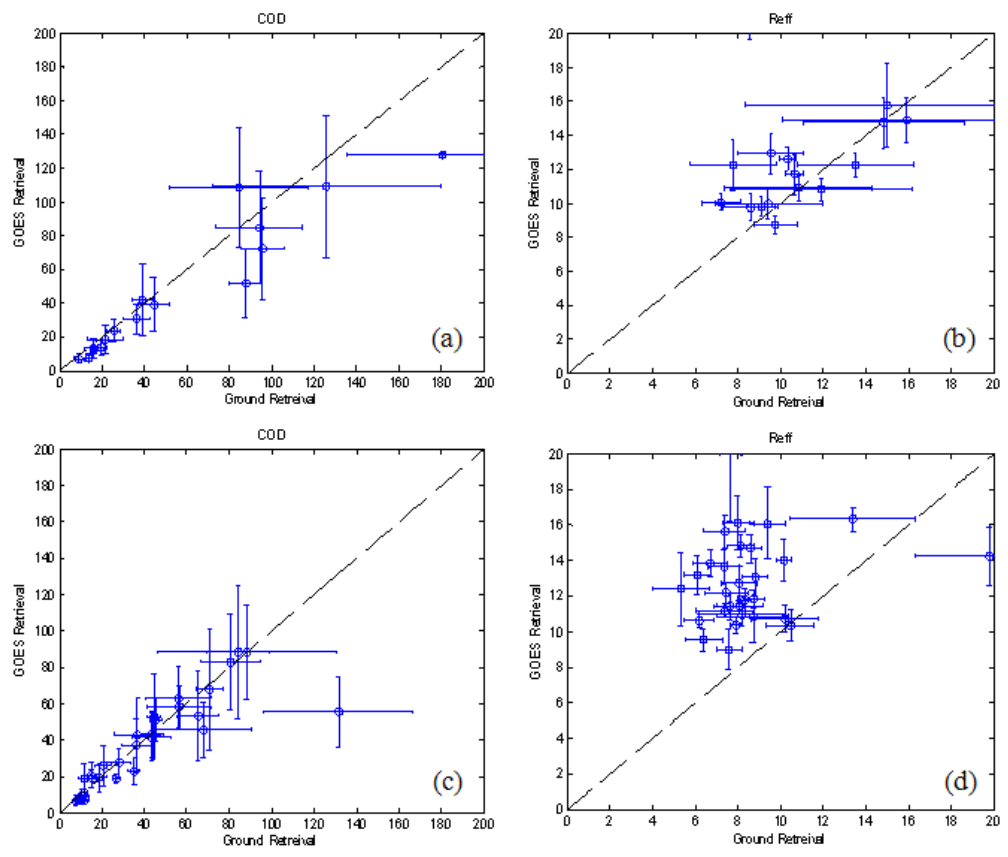
Figure 3. Comparison of VISST GOES cloud products against ground based retrievals— columns are respectively for COD and R θ < 50 degrees while the bottom row was filtered in the range 50 degrees < θ sun The horizontal and vertical error bars represent the standard deviations in ground and GOES retrievals respectively corresponding to both COD and R